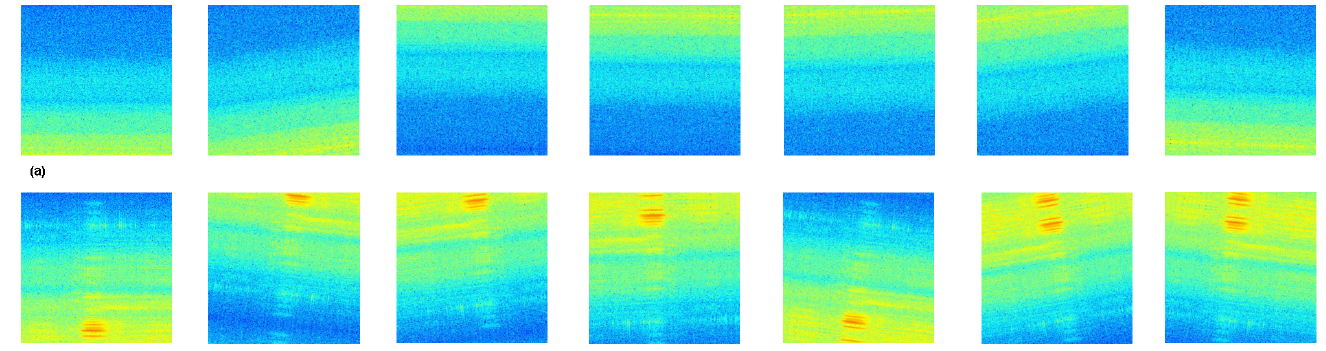
Figure 9. Image augmentation example: In line ( a ), starting from the left, the starting image relating to the No-Fault condition is shown and alongside six transformations of the first image by applying rotation, shift, zoom, horizontal and vertical flip. Line ( b ) shows the starting image relating to the Fault condition and alongside six transformations of the first image by applying rotation, shift, zoom, horizontal and vertical flip.